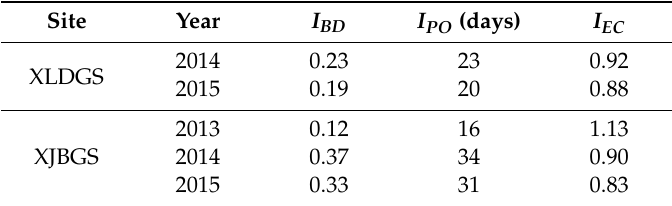
Table 2. Baseline deviation index ( I BD , Equation (1)), phase o ff set time index ( I PO , Equation (2)), extreme fluctuation index ( I EC , Equation (3)). We considered the monthly average water temperature at